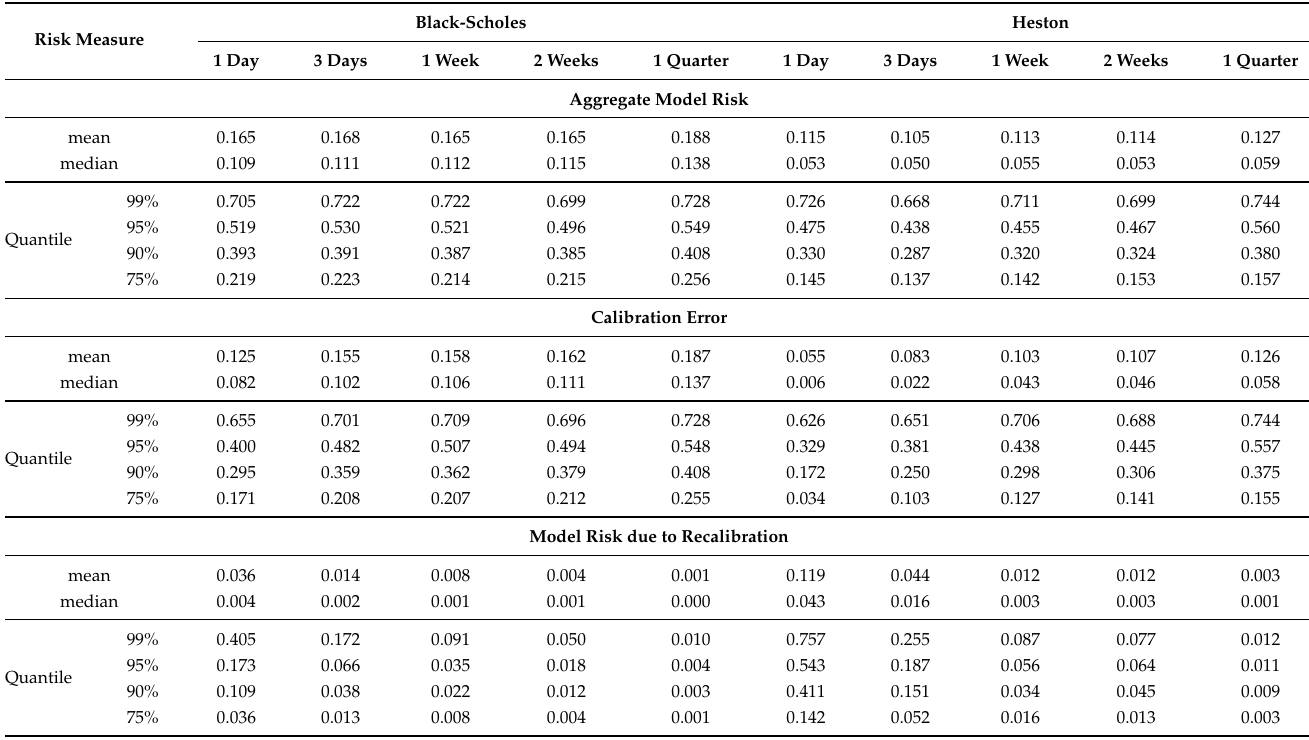
Table 2. Model risks (in terms of relative entropy) under different models and recalibration frequencies for GOOG. Black-Scholes Risk Measure